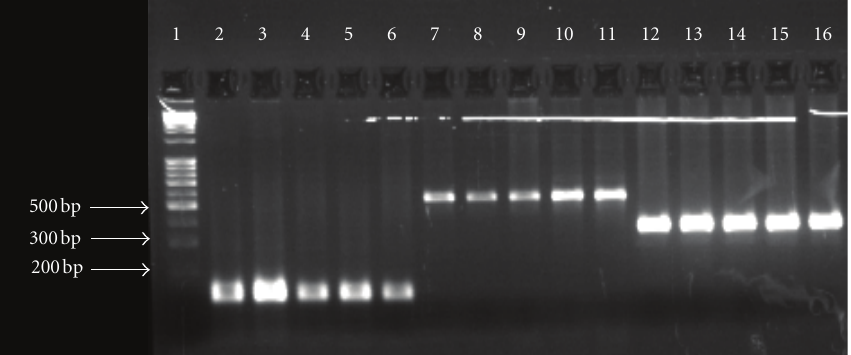
Figure 2: PCR showing 165, 365, and 541 bp target sequence amplified in case samples. Lane 1- gene marker, Lanes: 2–6, 165 bp amplicon, Lanes: 7–11; 541 bp amplicon, Lanes: 12–16, 365 bp amplicon. Table 2: Detection of mycobacterial infection by polymerase chain reaction.